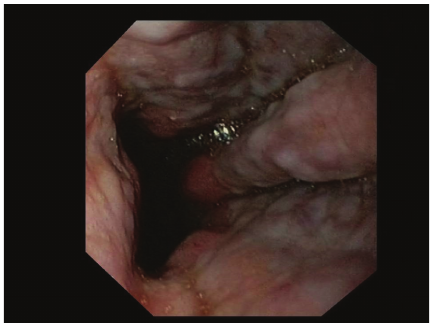
Figure 1: Grade III esophageal varices visualized by endoscopic ultrasound technique.